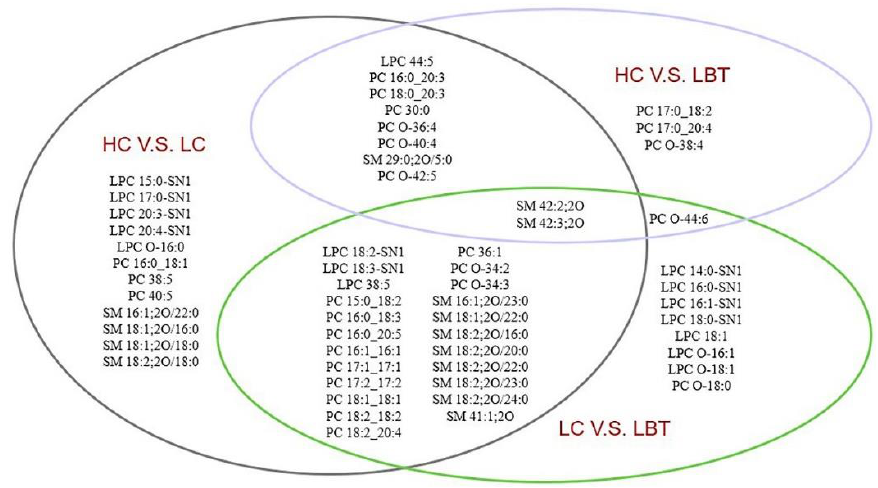
Figure 3. Significantly different lipids from across LC, LBT, and HC groups (LC, laryngeal cancer patients; LBT, laryngeal benign tumor patients; HC, healthy crowds).